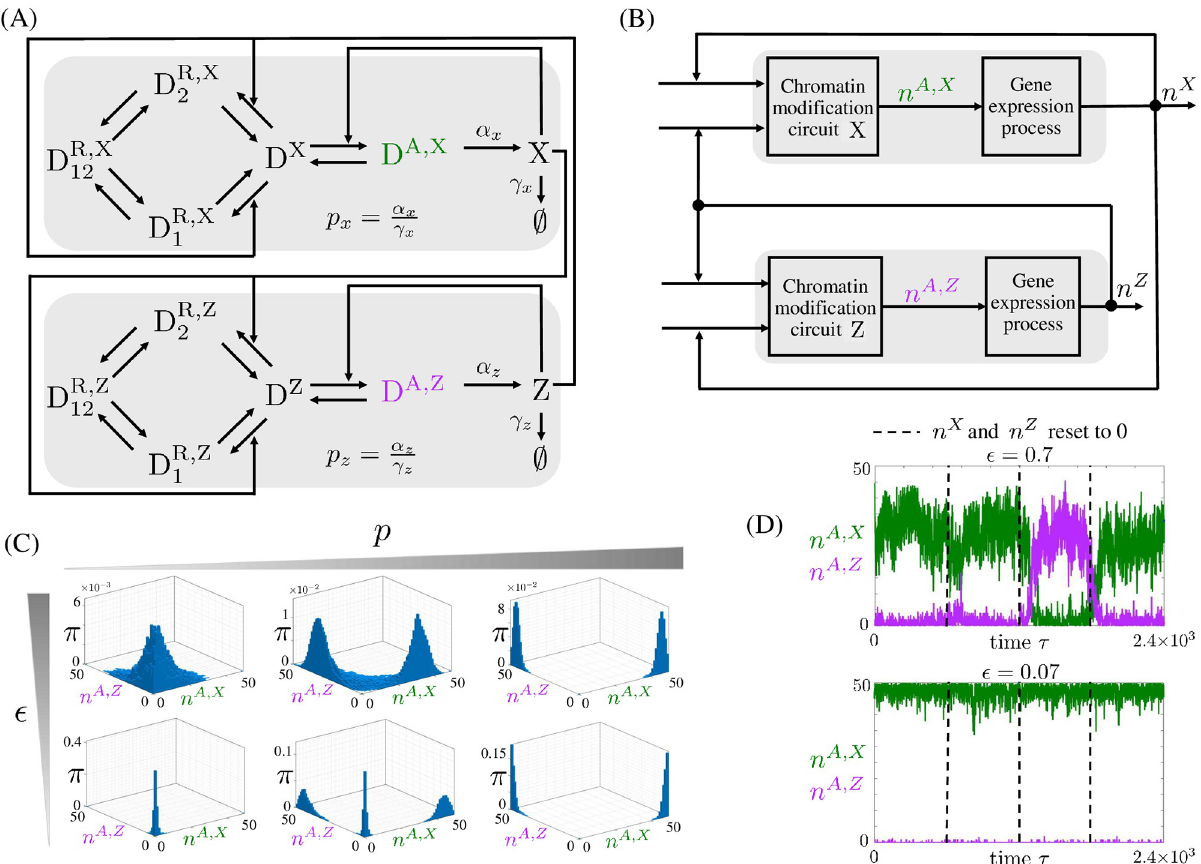
Fig 6. Mutual repression circuit: Robust memory of multiple co-existing gene expression patterns. (A) Interaction diagram of two mutually repressing and positively autoregulated genes, wherein the product of each gene recruits writers of repressive chromatin modifications to the other gene. Here, X and Z represent the products of the two genes. (B) Block diagram corresponding to the circuit in panel (A). Here, n X and n Z correspond to the number of molecules of X and Z, respectively. (C) Stationary probability distribution π of the system obtained by simulating the reactions listed in Tables E and F in S2 File with the SSA, in which n A , ℓ with ℓ = X , Z represents the number of nucleosomes in each gene with activating histone modifications. In (C), p = p = p with p = 0, 0.1, 10 and � = 0.48, 0.2. The parameter values of each plot are listed in Tables E and F in S2 File. For all x z simulations we have μ = 1, μ 0 = 0.6, and � 0 = 1 (Figs G-I in S2 File show different parameter values). (D) Time trajectories of n A , X and n A , Z starting from n A , X = D tot and n A , Z = 0, in which n X and n Z are reset to zero at the indicated times (dashed line). Time is normalized with respect to k A M parameter values for each panel are listed in Tables G and H in S2 File. In particular, p = 0.15, μ 0 = 0.6, μ = 1, � = 1 and � as indicated. In all plots, we assume equal parameters for both chromatin modification circuits. In our model, � , defined in Eq (2), is a non-dimensional parameter that quantifies the time scales of basal erasure rate of all modifications relative to those of auto and cross-catalysis. In all plots ( n A , ℓ , n R , ℓ ) � (50, 0) and ( n A , ℓ , n R , ℓ ) � (0, 50) correspond to the active and repressed state of gene ℓ , with ℓ = X , Z . In the figure, we use green and purple, respectively, to indicate D A,X and D A, Z and related quantities.